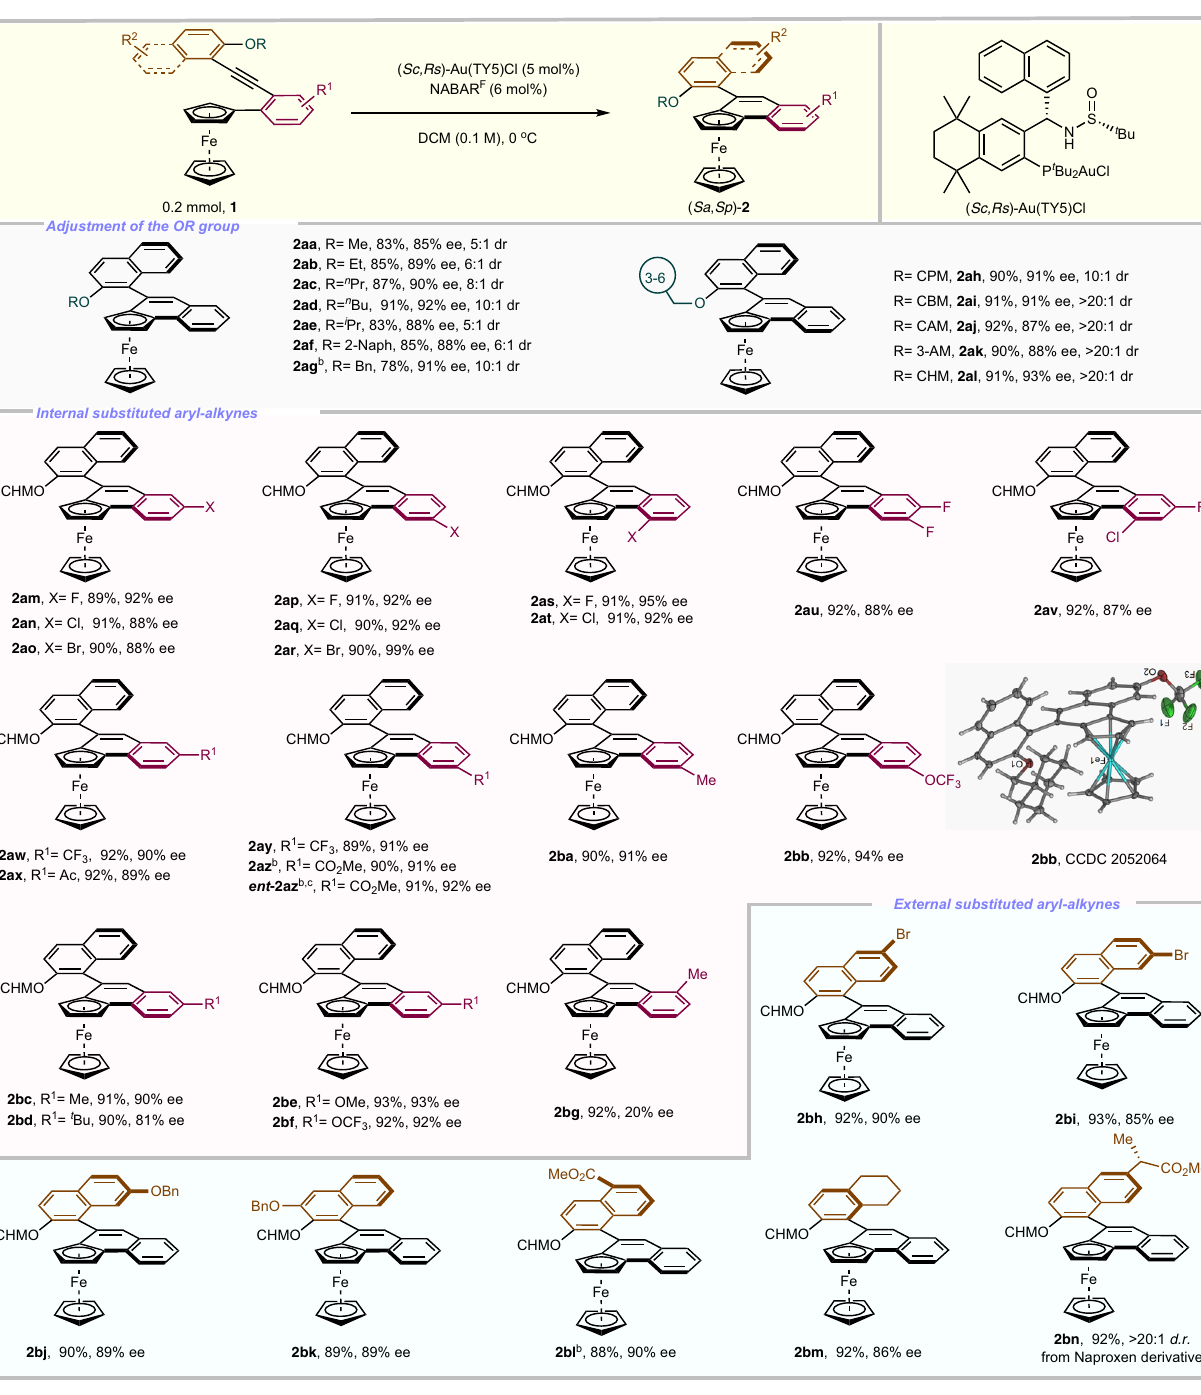
Fig. 3 Exploration of substrate scopea. a Reaction conditions: unless otherwise noted, all reactions were carried out with 0.2 mmol of 1 , Au(TY5)Cl (5 mol %), NaBAr F (6 mol%) in 2.0 mL DCM at 0 °C; isolated yields; the ee values were determined by chiral HPLC, >20:1 dr. b Au(TY5)Cl (10 mol%), NaBAr F (12 mol%). c ( Rc , Ss )-Au(TY5)Cl. CPM Cyclopropylmethyl, CBM Cyclobutylmethyl, CAM Cycloamylmethyl, AM amylmethyl, CHM